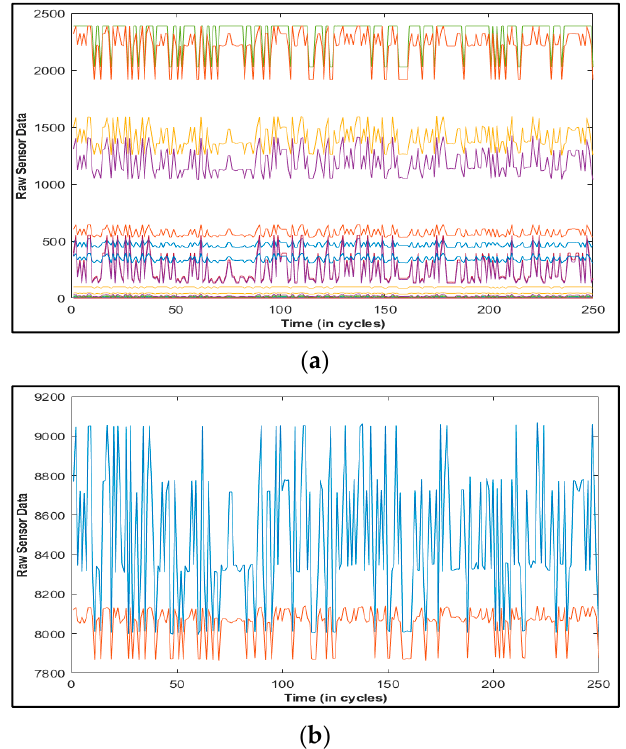
Figure 2. ( a ) Raw data from the engine source in the range of [0, 2500]; ( b ) Raw data from the engine source in the range of [7000, 9000].